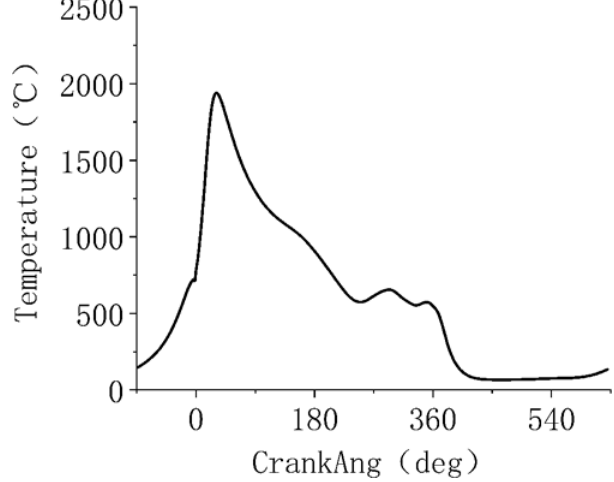
Fig. 6. Combustion chamber temperature variation curve with crankshaft rotation